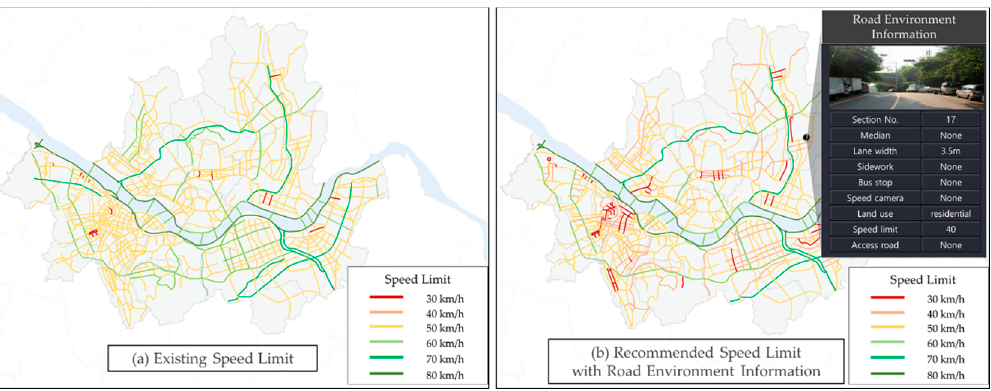
Figure 21. GIS-based visualization of speed limit information.